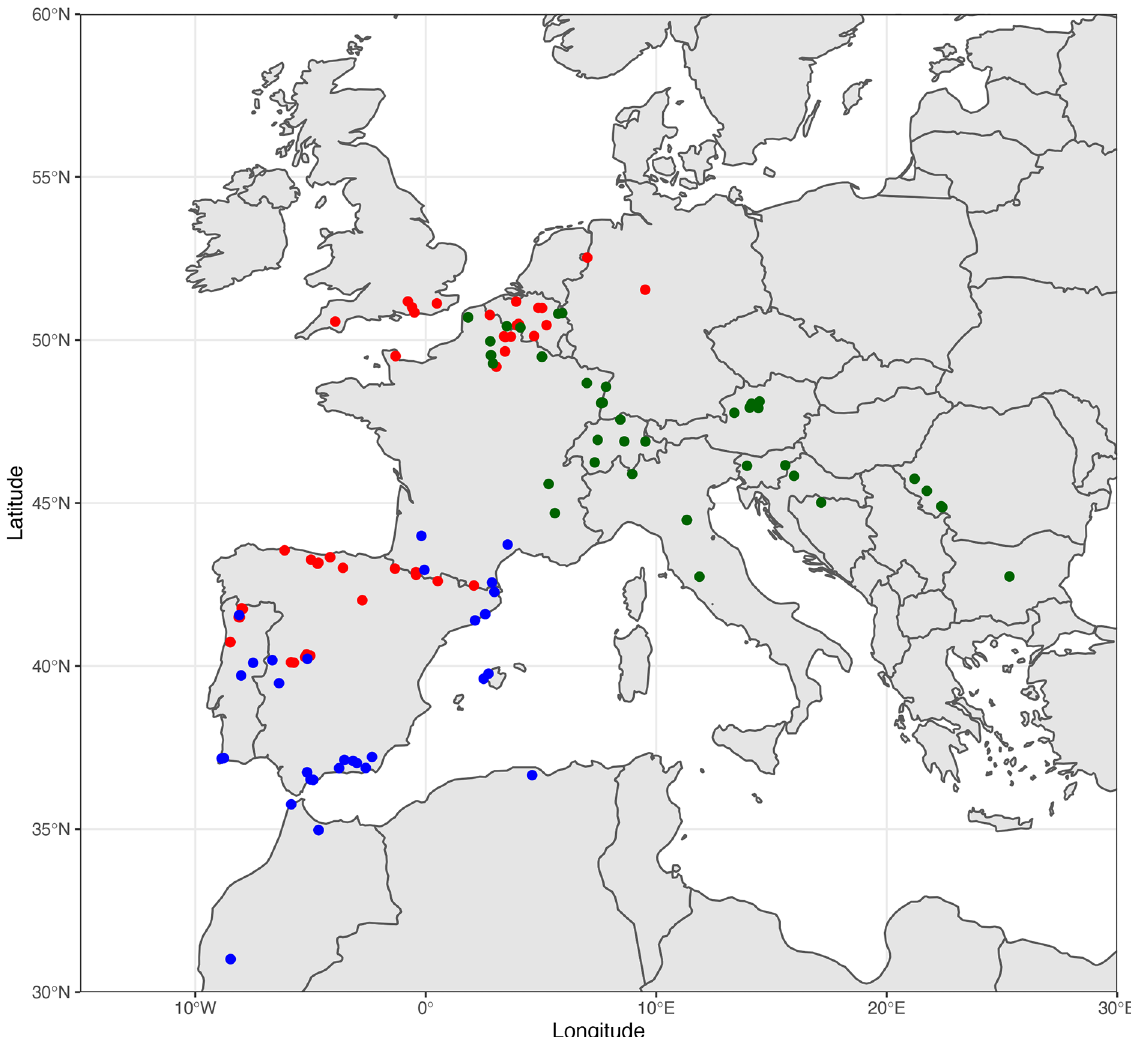
Fig. 84. Records of Andrena ( Ptilandrena ) angustior (Kirby, 1802) [red dots], A. ( P. ) fulvata Stoeckhert, 1930 [green dots] and A. ( P. ) impressa Warncke, 1967 stat. nov. [blue dots] showing Atlantic, Continental and West Mediterranean distributions, respectively. Records presented here are not